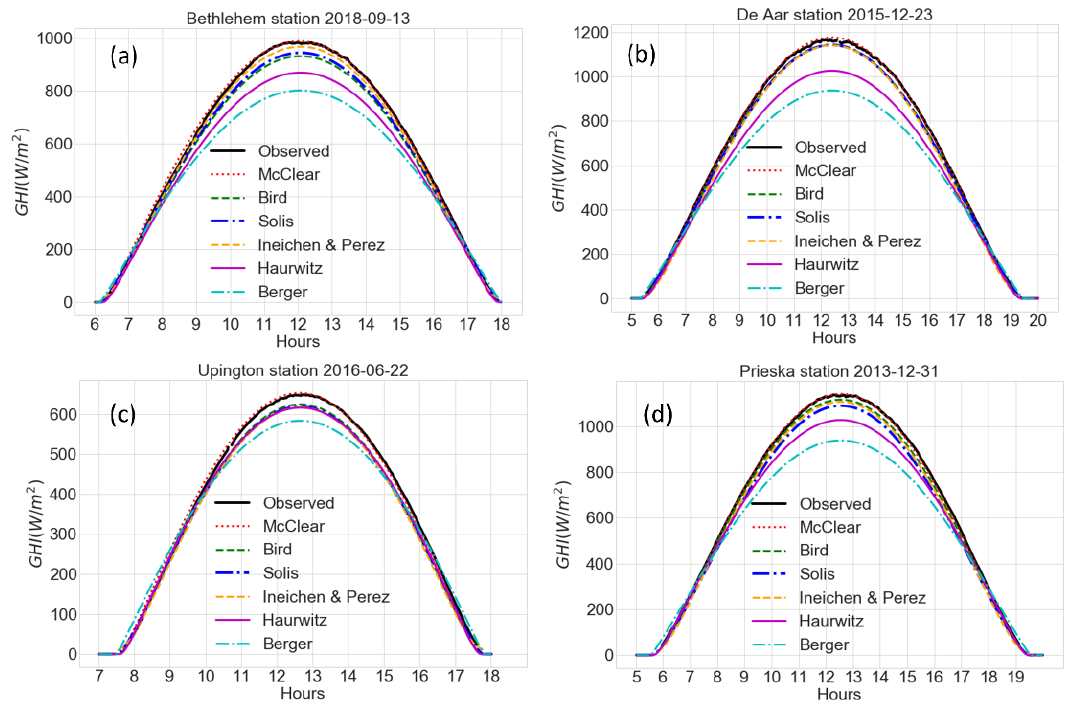
Figure 6. Comparison between observed and modelled minute GHI values in Bethlehem ( a ), De Aar ( b ), Upington ( c ), and Prieska ( d ).